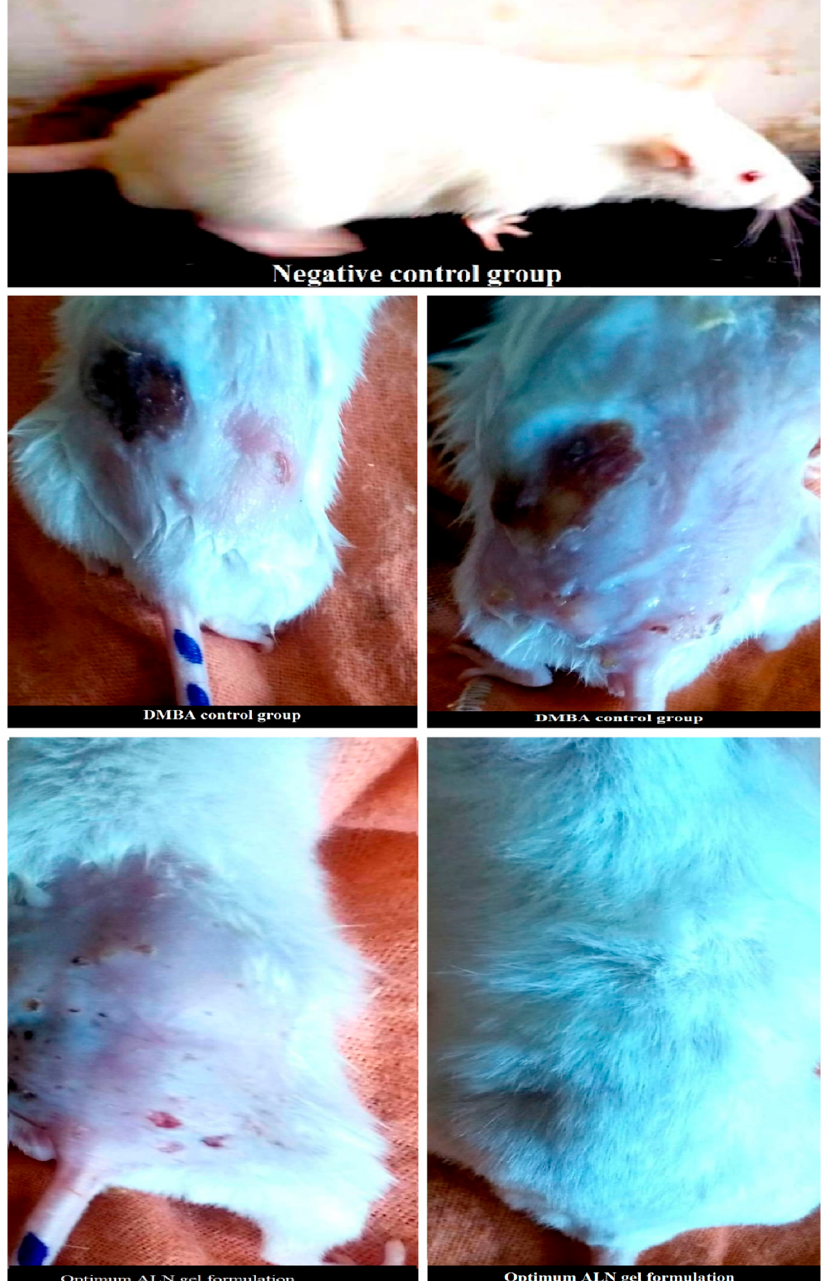
Figure 5. Representative images of carcinoma in optimum ALN gel formulation treated rats compared to DMBA control.